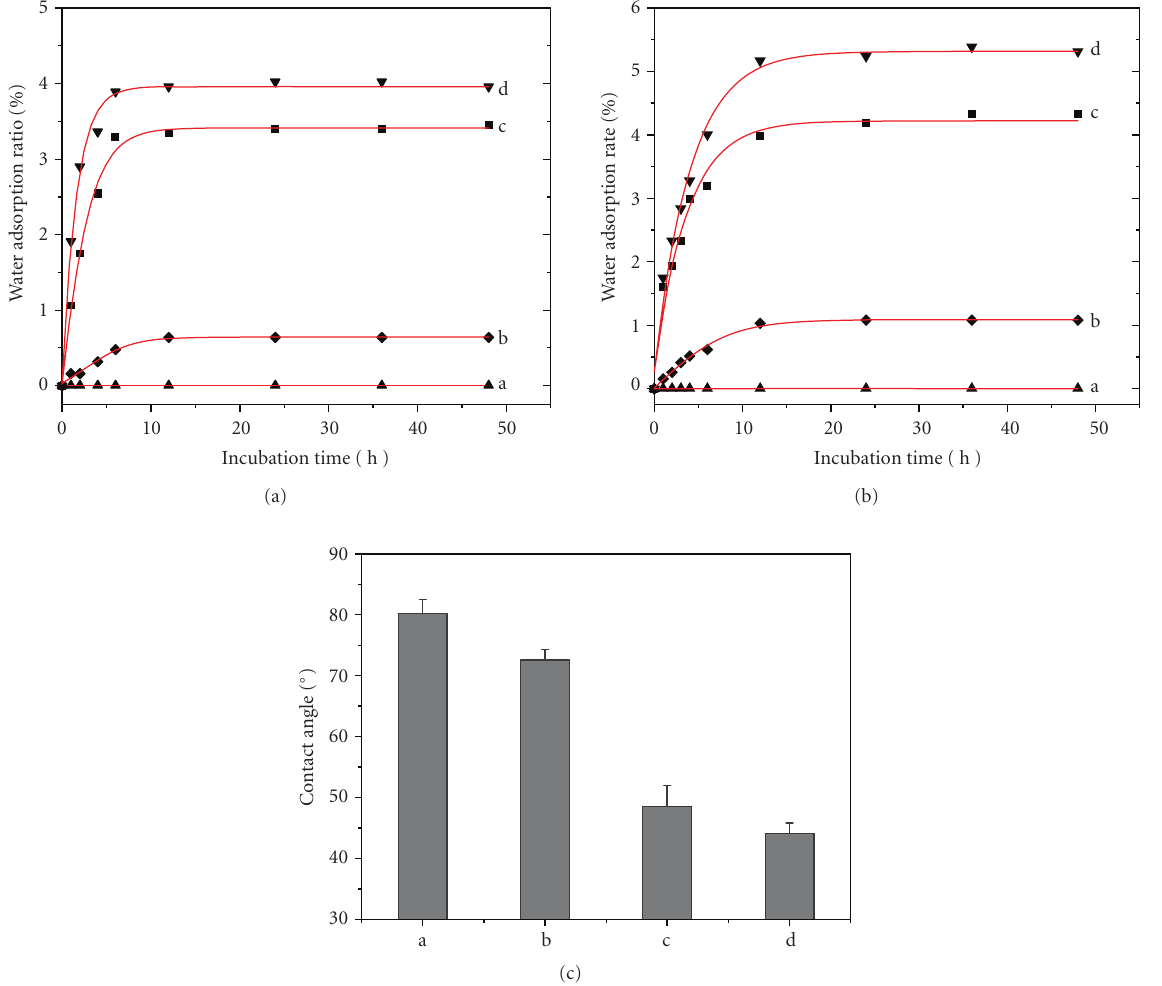
Figure 5: Water absorption of di ff erent PU films; a: PU, b: PU-NH 2 , c: PU-HA 1 , d: PU-HA 4 in PBS (a), deionized water (b), (c) contact angle